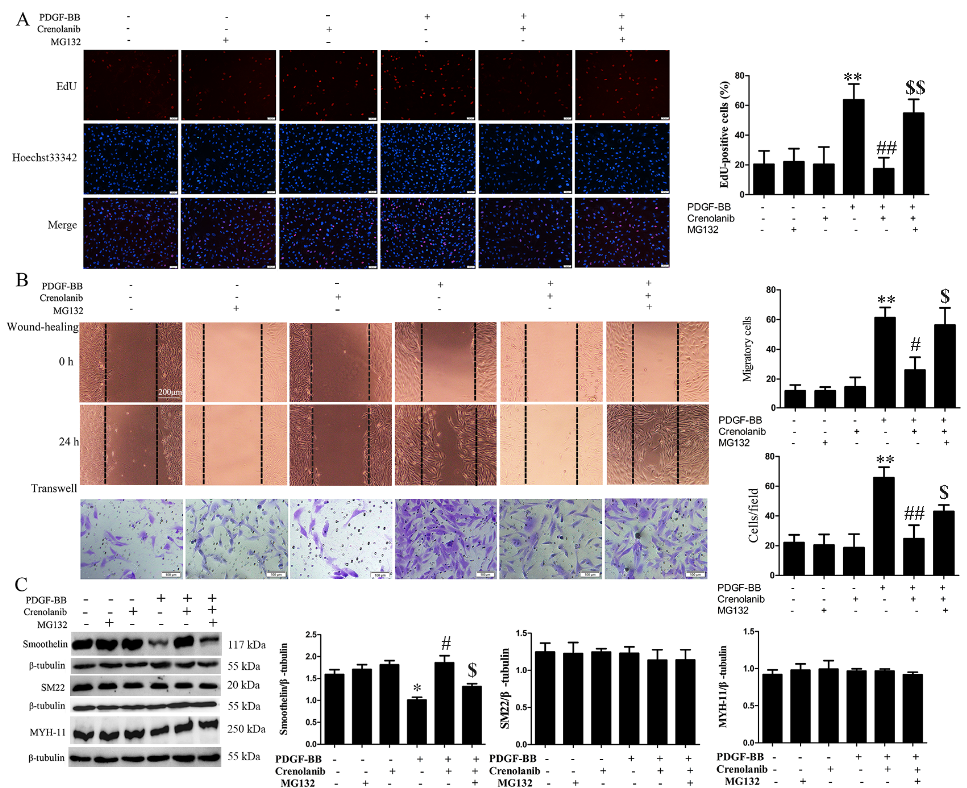
Figure 2. MG132 pretreatment blocks the reduced phenotypic transition of HA-VSMCs induced by crenolanib. HA-VSMCs were pretreated with crenolanib (50 nM) for 48 h or MG132 (5 µ M) for 1 h and then exposed to 10 ng/mL PDGF-BB treatment for 24 h. Untreated cells were used as control. ( A ) Cell proliferation was checked by EdU assay (scale bar = 100 µ m). Histogram showing the ratio of EdU-positive cells (red) to the total number of cells. **, p < 0.01 vs. the control group; ##, p < 0.01 vs. the group treated with PDGF-BB; $$, p < 0.01 vs. the PDGF-BB and crenolanib-treated group ( n = 3). ( B ) Cell migration was checked by wound-healing (scale bar=200 μ m) and transwell assays (scale bar=100 μ m). Histograms showing the quantification of the wound healing (migrating cells from the scratched boundary) and transwell assay (crystal violet stained cells migrating to the lower chamber) results. **, p < 0.01 vs. the control group; #, p < 0.05 and ##, p < 0.01 vs. the PDGF-BB-treated group; $, p < 0.05 vs. the PDGF-BB and crenolanib-treated group ( n = 3). These results show that MG132 pretreatment promoted the reduced cell proliferation and migration mediated by crenolanib. ( C ) Western blot analysis of MYH-11, SM22, and smoothelin. MG132 reduced the increased smoothe- lin expression induced by crenolanib. Histograms showing the ratios of target proteins to β -tubulin. *, p < 0.05 vs. the control group; #, p < 0.05 vs. the PDGF-BB-treated group; $, p < 0.05 vs. the PDGF-BB and crenolanib-treated group ( n =